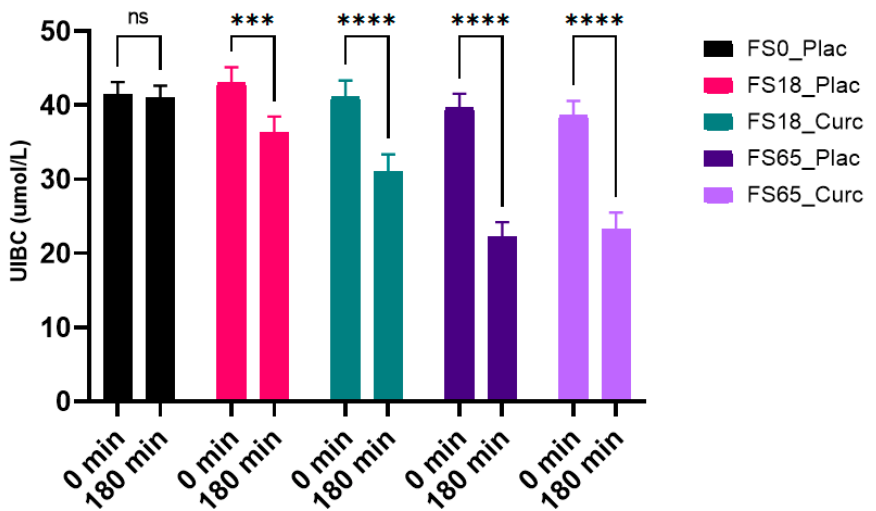
Figure 4. Effect of 180 min supplementation on mean serum unsaturated iron-binding capacity (UIBC, µmol/L) levels (mean, SEM). * represents significance values when comparing time points within the same the conditions (*** p = 0.0002, **** p < 0.0001); ns indicates no significant difference ( p > 0.05).